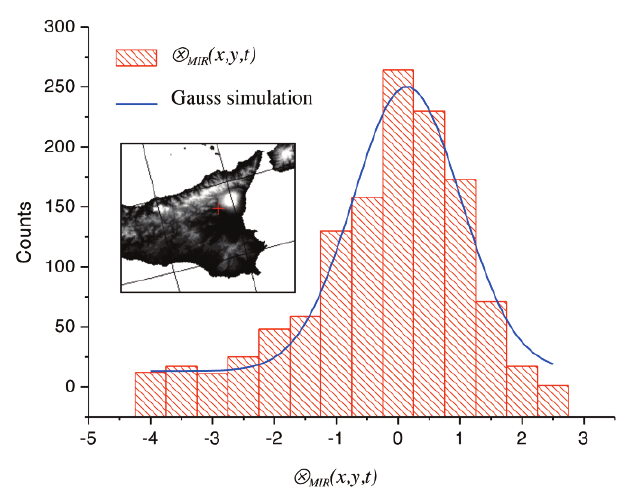
Figure 2. Histogram of the , ( x , y , t ) index computed for a single MIR unperturbed pixel selected over a nonvolcanic area close to the Mount Etna edifice on ten years of satellite records, with mean = –0.13 and sigma = 1.13. Inset: Digital elevation model GTOPO 100 with red cross to indicate the location of the unperturbed